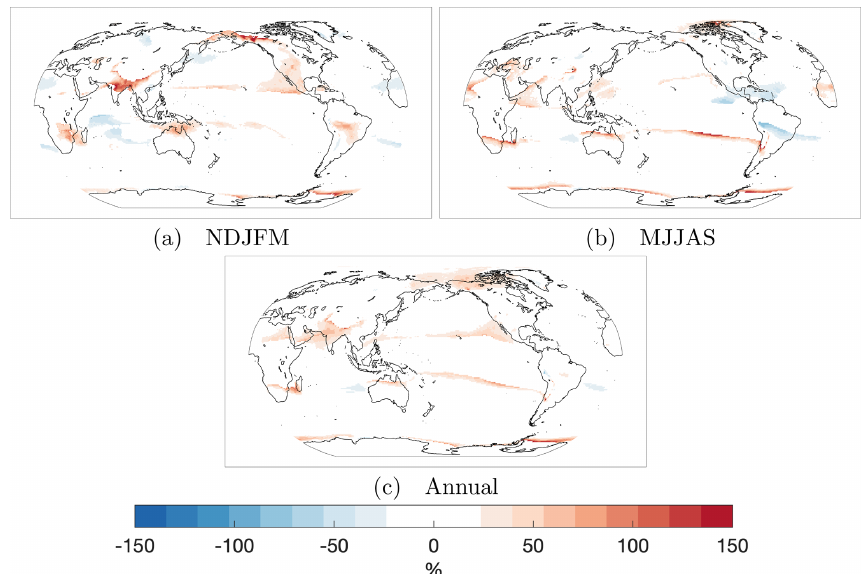
Figure A2. The AR relative frequency differences (as opposed to absolute frequency differences) by percentage corresponding with Fig. 1c, f, and i. Only grid points with MERRA2 AR frequencies (absolute) of at least 3% are shown (regions with very low AR frequencies can show relative differences of 100% due to a single extra time